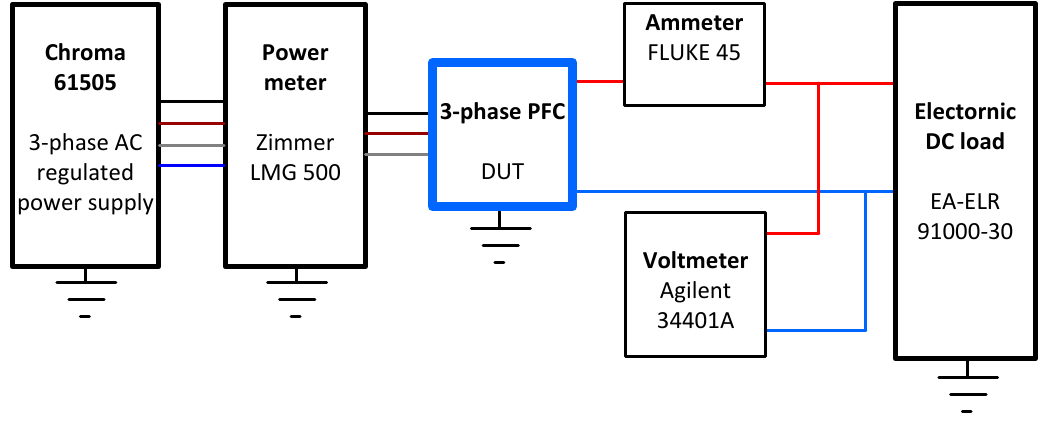
Figure 8. Block diagram of the experimental test-bench.